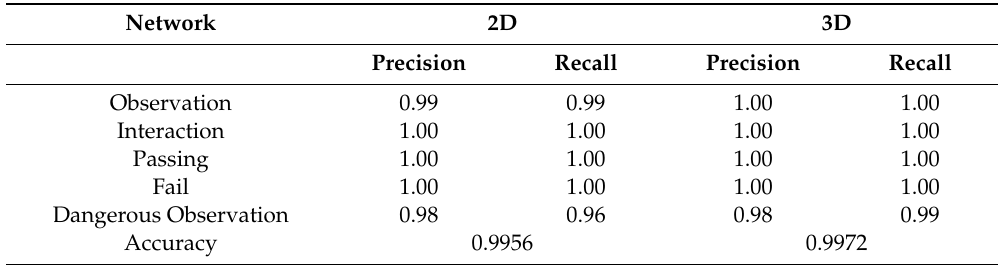
Table 1. Precision and recall of two trained networks for human action recognition.